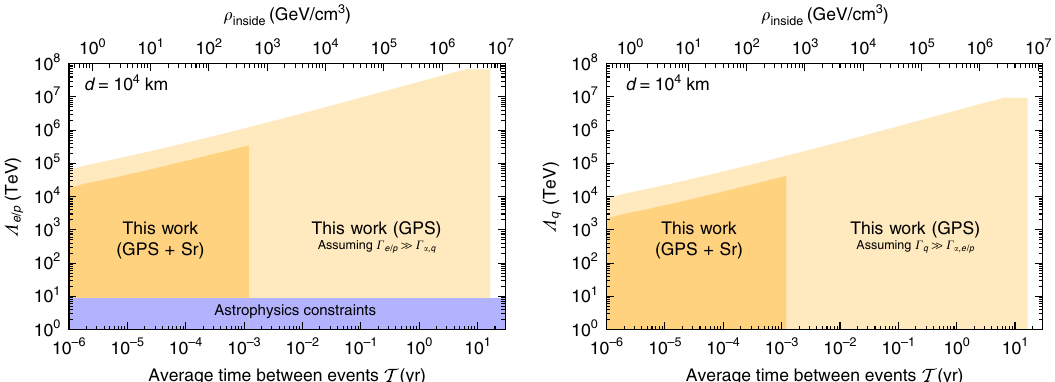
Fig. 6 Constraints on the coupling of dark matter to fermion masses. Limits (90% con fi dence level) on the energy scales Λ e / p and Λ q as a function of the average time between encounters, T , for constant d = 10 4 km. The lighter yellow regions are the limits from the Rb Global Positioning System sub-network in the assumption that the respective couplings dominate the interactions. The darker region combines our limits (from the Rb and Cs sub-networks) with the limits on Λ α from the Sr optical clock constraints 38 to place assumption-free limits on Λ e / p and Λ q . The blue region shows the astrophysical bounds for